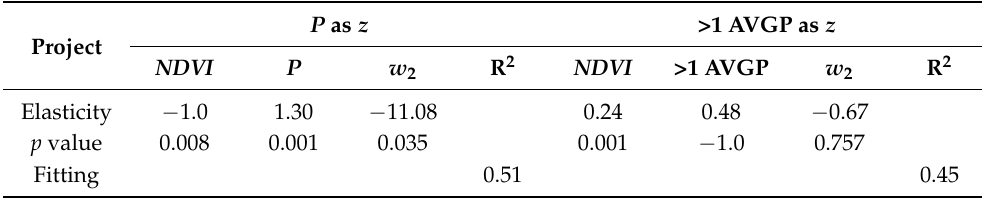
Figure 5. Correlation between climate change and ecological restoration on sediment concentration C: precipitation ( P ), total precipitation greater than 1 mm (>1 TP), average precipitation greater than 1 mm (>1 AVGP), total precipitation greater than 10 mm (>10 TP), average precipitation greater than 10 mm (>10 AVGP), total precipitation greater than 30 mm (>30 TP), average precipitation greater than 30 mm (>30 AVGP) and aridity index (AI). The red line is the correlation trend of each element and C value of the year, and the black box is the corresponding C value of each element of the year. Table 5. Elasticity and significance of logarithmic function of climate change and ecological restoration on sediment concentration C.